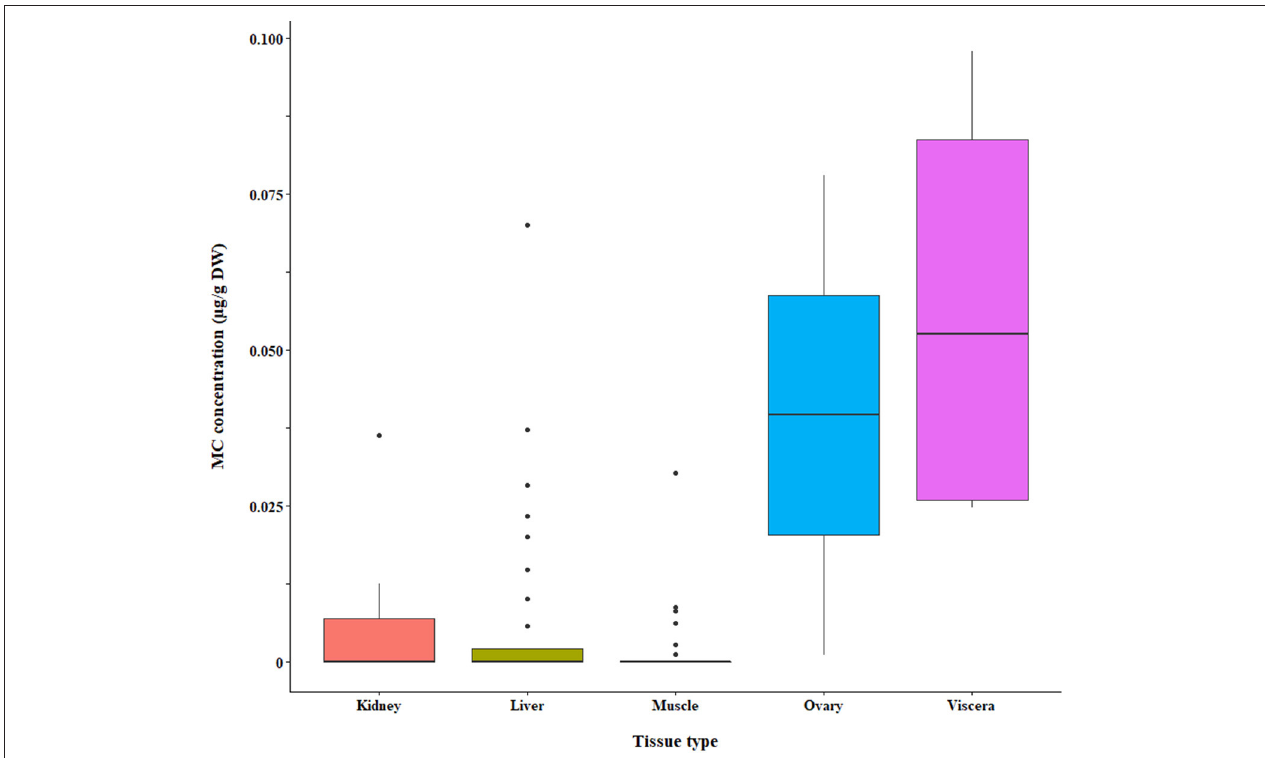
FIGURE 8 | Microcystin (MC) in fish tissues quantified by LC-MS/MS. A subset of the raw data is shown for which significant differences between tissue types were detected by bootstrap analysis of the